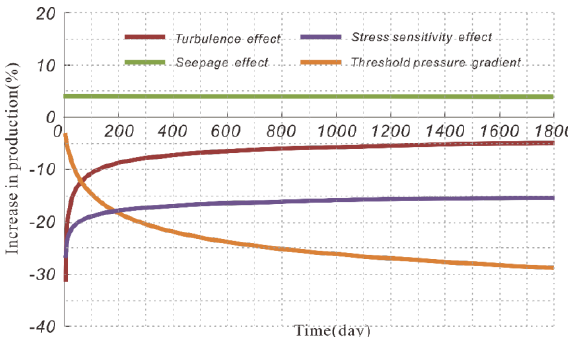
Figure 8. A schematic of the contribution of different factors to productivity at different periods.